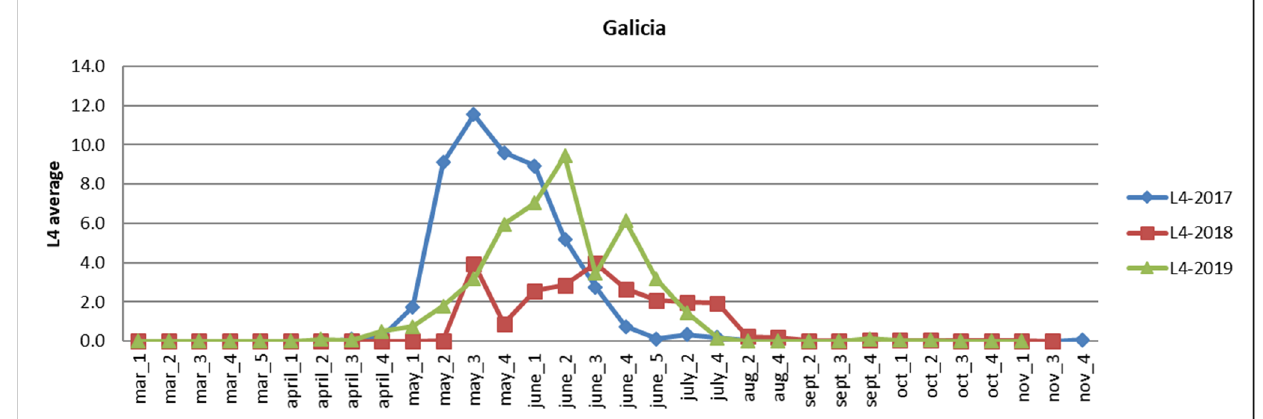
Figure 10. Evolution of the average number of larvae in stage L3, according to the week of the survey month.